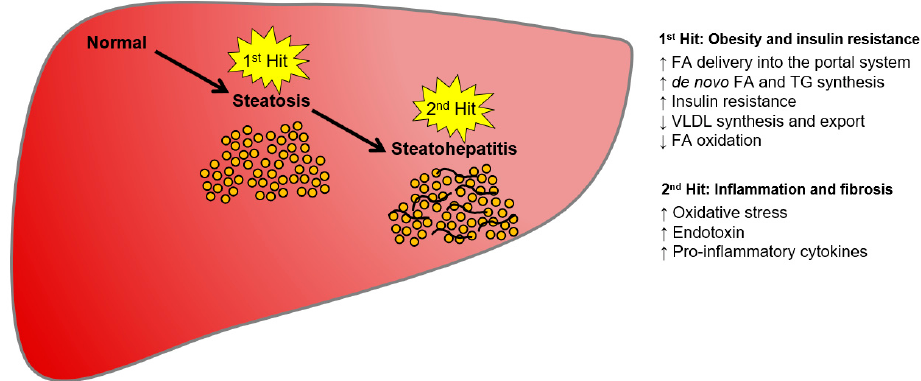
Figure 1. Schematic diagram of the two-hit hypothesis of non-alcoholic fatty liver disease (NAFLD) progression. In the first hit, an imbalance of lipid synthesis, catabolism, and export results in lipid accumulation in liver (steatosis). Obesity and insulin resistance are strongly correlated with liver steatosis. In the second hit, further inflammation processes lead to non-alcoholic steatohepatitis (NASH) and fibrosis, which can evolve into more severe stages, such as cirrhosis and ultimately hepatocellular carcinoma.